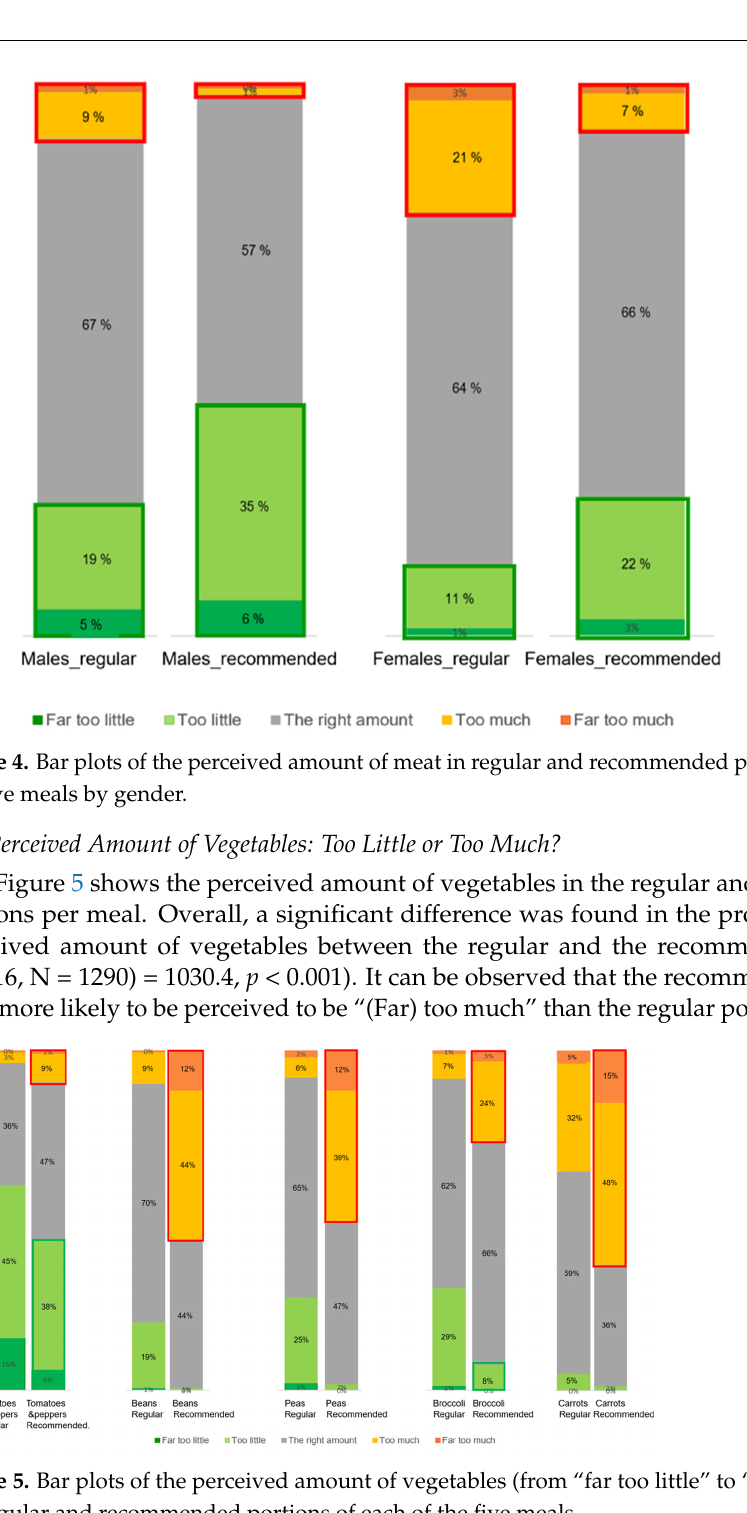
Figure 6. Bar plots of the evaluation of perceived amount of vegetables in regular and recommended portion sizes across the five meals by gender. 3.5. Estimations of the “Normal Portion Size” of Meat and Vegetables Table 3 displays the estimations of the normal portion sizes of the meat and vegeta- bles for males and females. Overall, 64% of males considered the “ regular ” and the “ extra- large ” portions as their “normal” amount of meat, whereas more females (32%) than males (15%) considered the “ recommended ” and the “ extra-small ” portions as their normal amounts of meat. These data are consistent with the results on meat in Figure 4. Regarding vegetables, the gender difference in the estimation of normal portion size was less evident than with meat. The distributions of responses of men and women were quite similar re- garding the estimated normal portion size of vegetables, which is consistent with the data in Figure 6.